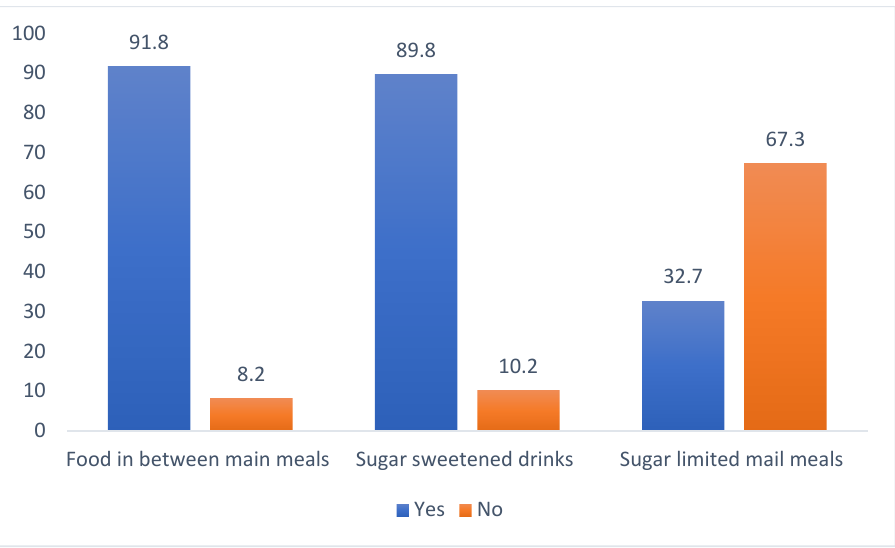
Figure 2. Frequency of food and sugar intake among the study participants. Table 3. Relationship between BMI and clinical parameters among the study